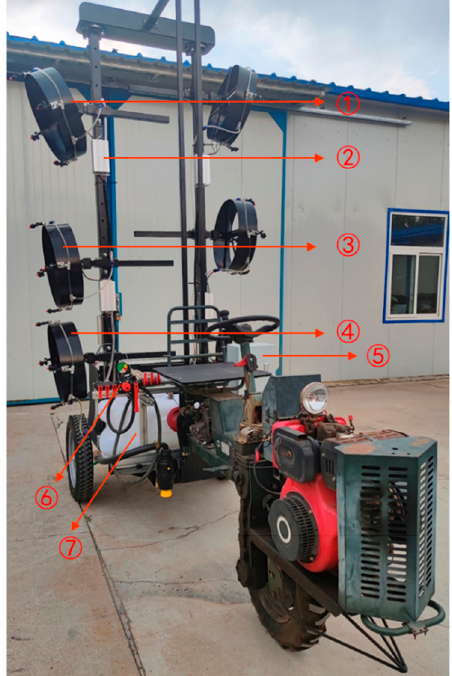
Figure 1. The multi-unit air-assisted orchard sprayer used in this study: ① Top Unit, ② Electronic Speed Control, ③ Middle Unit, ④ Bottom Unit, ⑤ Speed control box, ⑥ Proportional control valve with pressure gauge, ⑦ Tank.